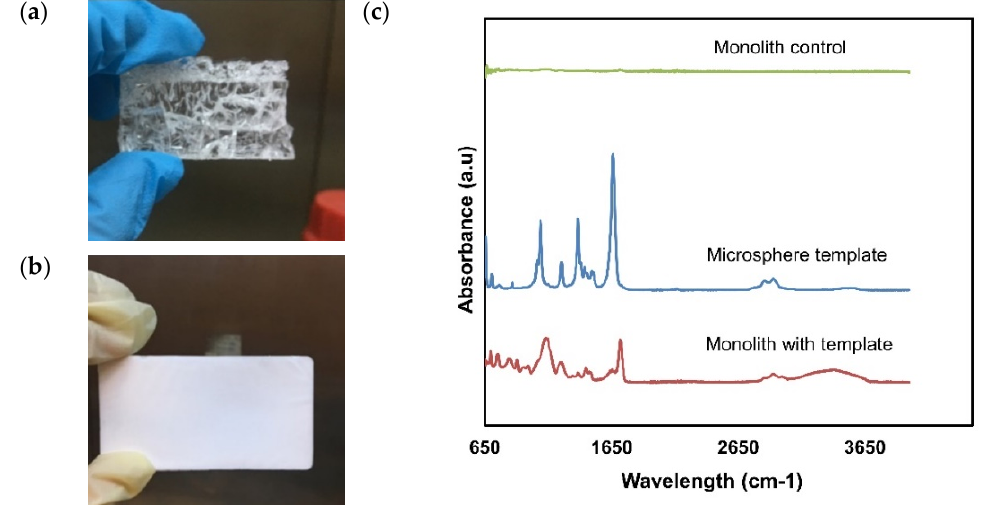
Figure 5. Physical observation of monolith ( a ) without template and ( b ) with template, and ( c ) FTIR spectra of microsphere templates and monoliths with and without template.